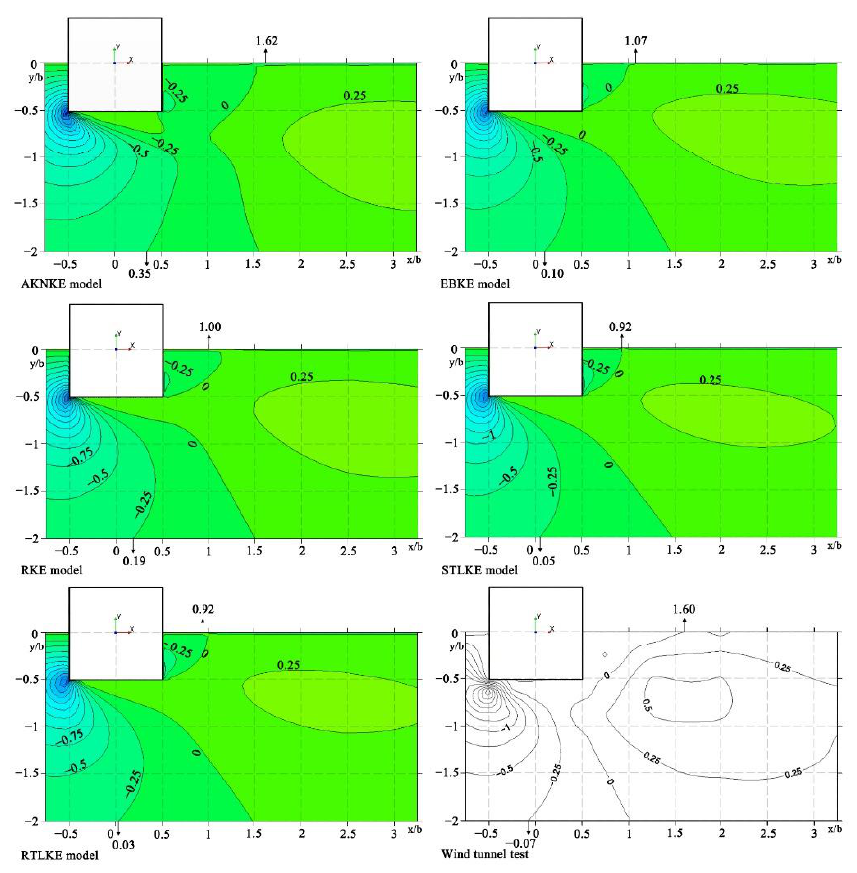
Figure 14. Contour plots of Y-velocity ( V ) at z/b = 1.25. Table 9. Location of contour line at z/b = 1.25 ( V ).